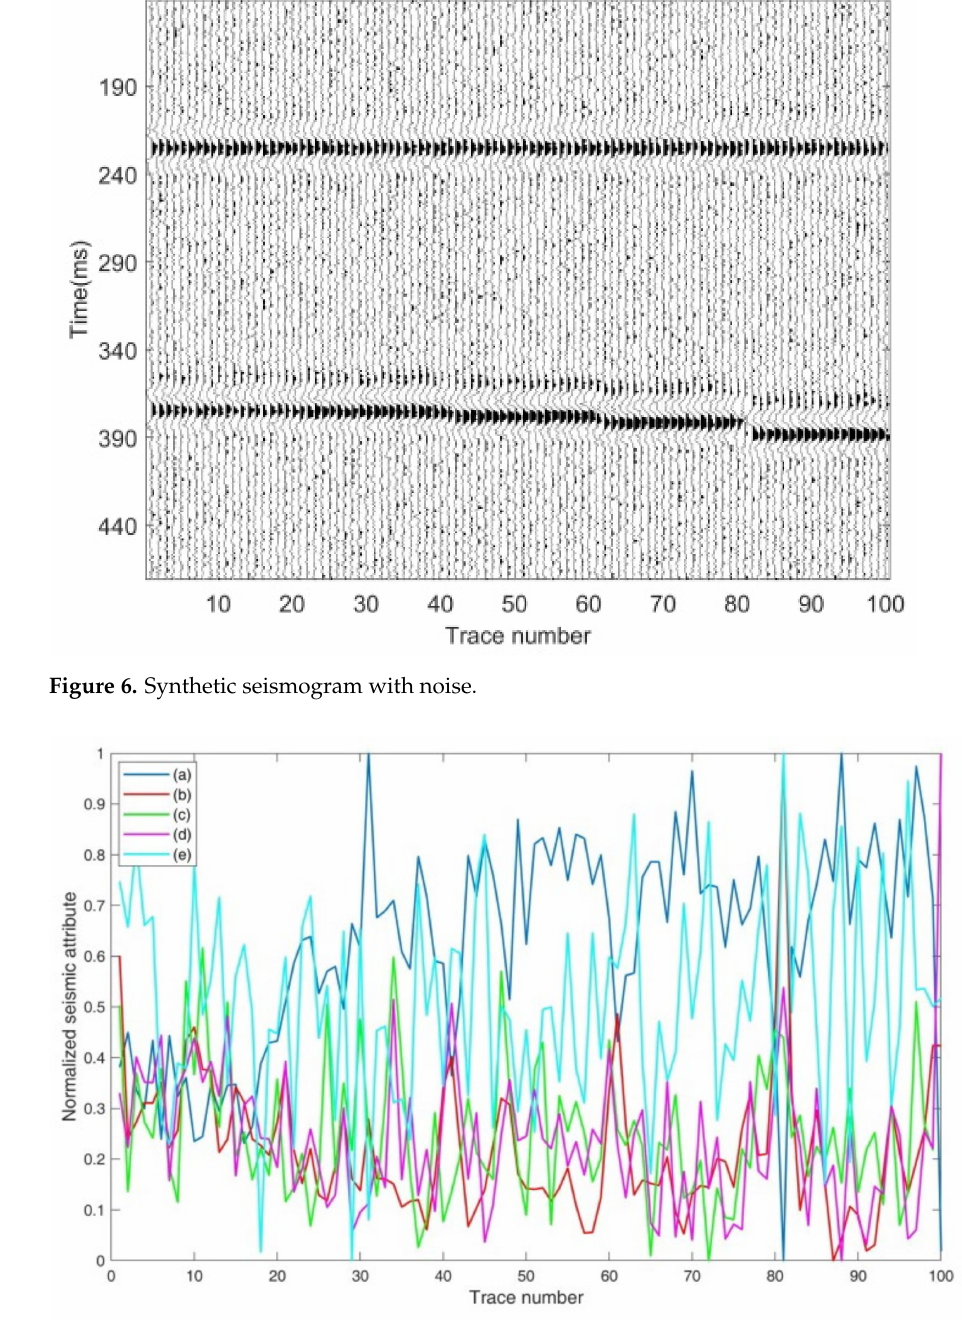
Figure 7. Normalization of the seismic attributes of the synthetic seismogram with noise: ( a ) instan- taneous amplitude attribute; ( b ) waveform difference attribute; ( c ) instantaneous frequency attribute; ( d ) frequency bandwidth attribute; and ( e ) attenuation coefficient